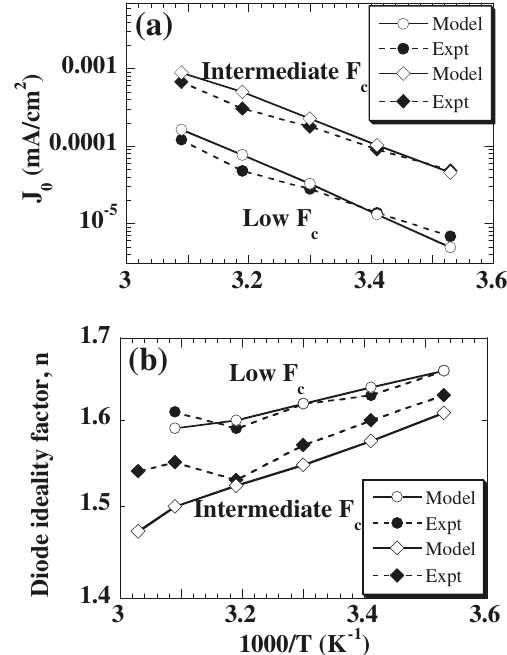
Fig. 4. Calculated values (open symbols) of (a) the reverse saturation current density ( J 0 ) and (b) the diode ideality factor ( n ) for low and intermediate F c μ c-Si:H solar cells, compared to experiments (closed symbols) at temperatures from 10 ◦ C to 50 ◦ C. The lines are guides to the